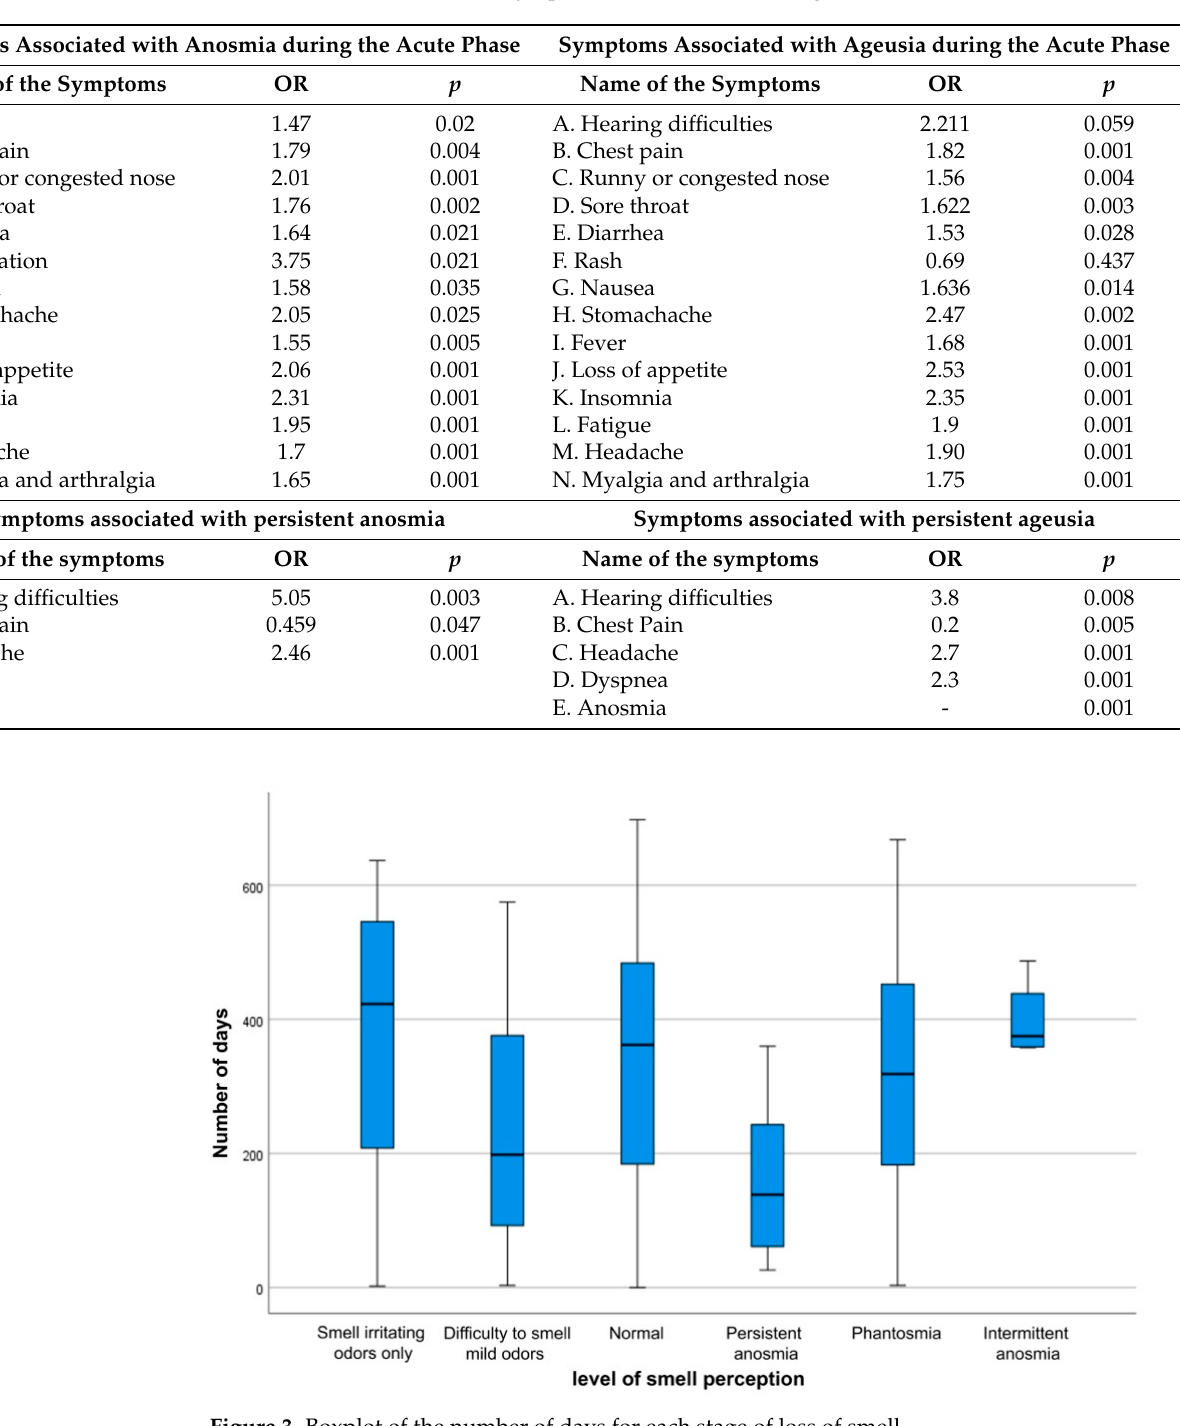
Figure 4. Boxplot of the number of days for each stage of loss of taste. 3.5. Factors Associated with Anosmia and Ageusia in Multivariable Analysis In multivariable analysis, anosmia during the acute phase was associated with BMI, asthma and shortness of breath, while anosmia during the post-acute phase was associ- ated with sex. Ageusia during the acute phase was associated with sex, myalgia, and ar- thralgia, while ageusia in the post-acute phase was associated with sex (Table 6).